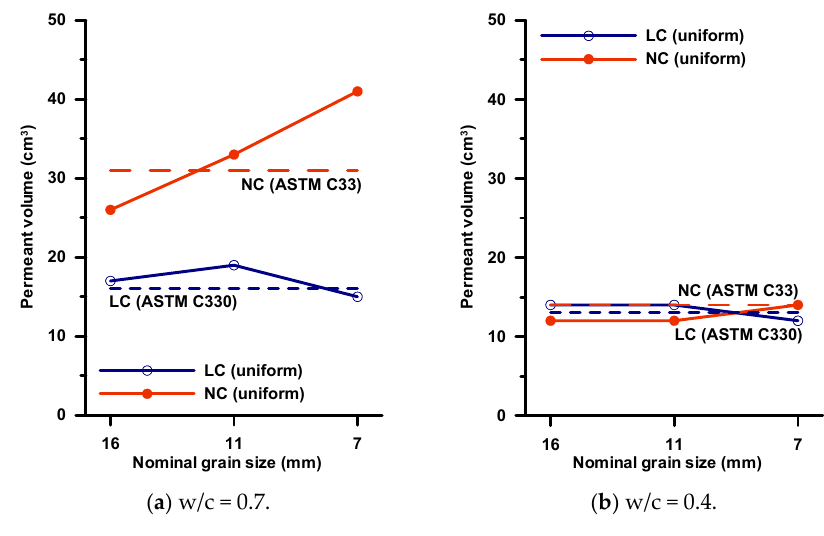
Figure 8. Permeability of NWC and LWAC.